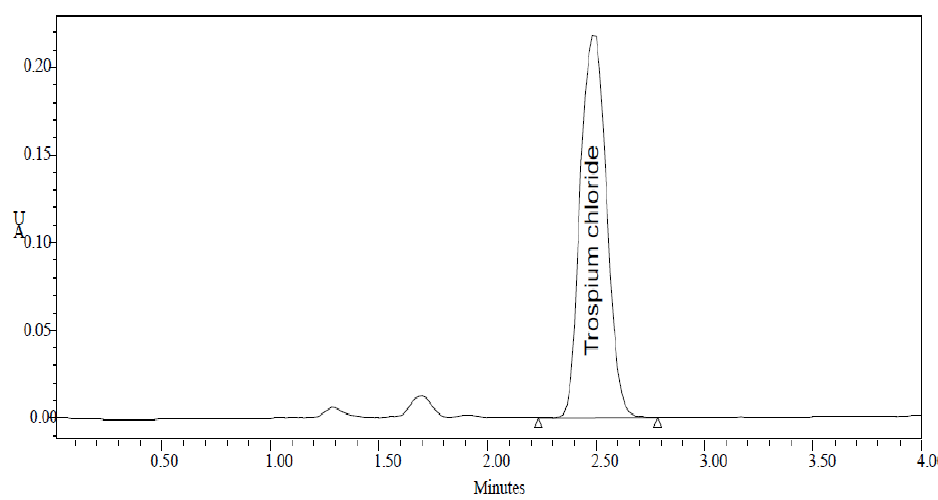
Figure 2: Typical chromatogram showing separation of trospium